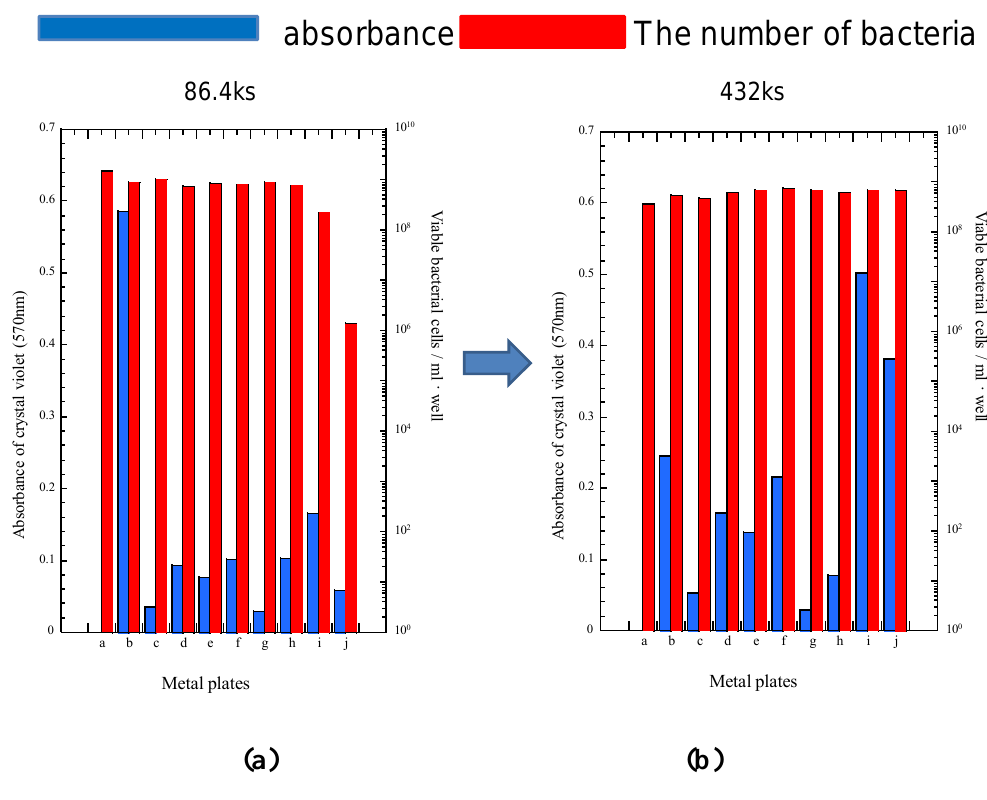
Figure 5. Biofilm formation of Pseudomonas aeruginosa on surface of various specimens. (a) immersion time: 24 hours; (b) immersion time: 120 hours. The number of bacteriaabsorbance 86.4ks